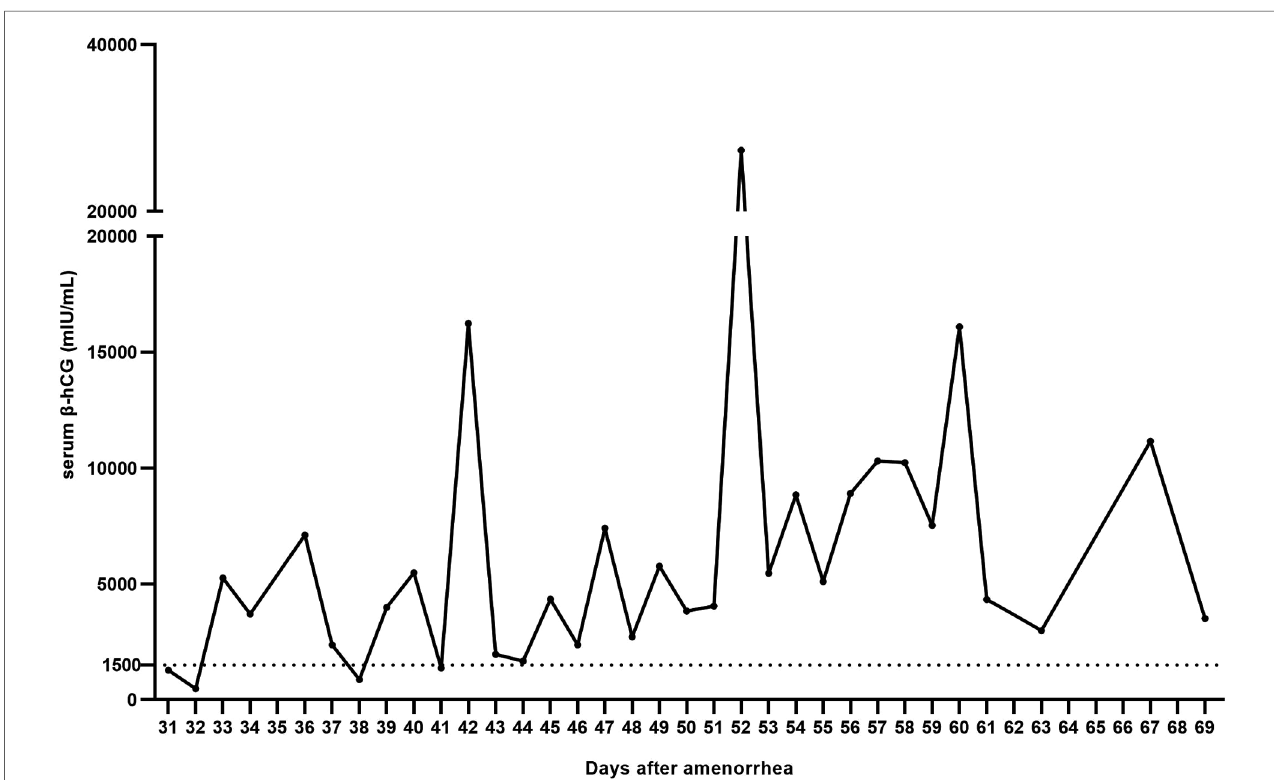
FIGURE 1 Mean serum β -hCG levels of ovarian pregnancy patients on different days after amenorrhea. Two ovarian pregnancy cases with intrauterine pregnancy were excluded. Most of the mean values exceeded 1500 mIU/ml, and the highest and the lowest mean levels were 27,353 mIU/ml (52 days after amenorrhea) and 478.025 mIU/ml (32 days after amenorrhea), respectively.